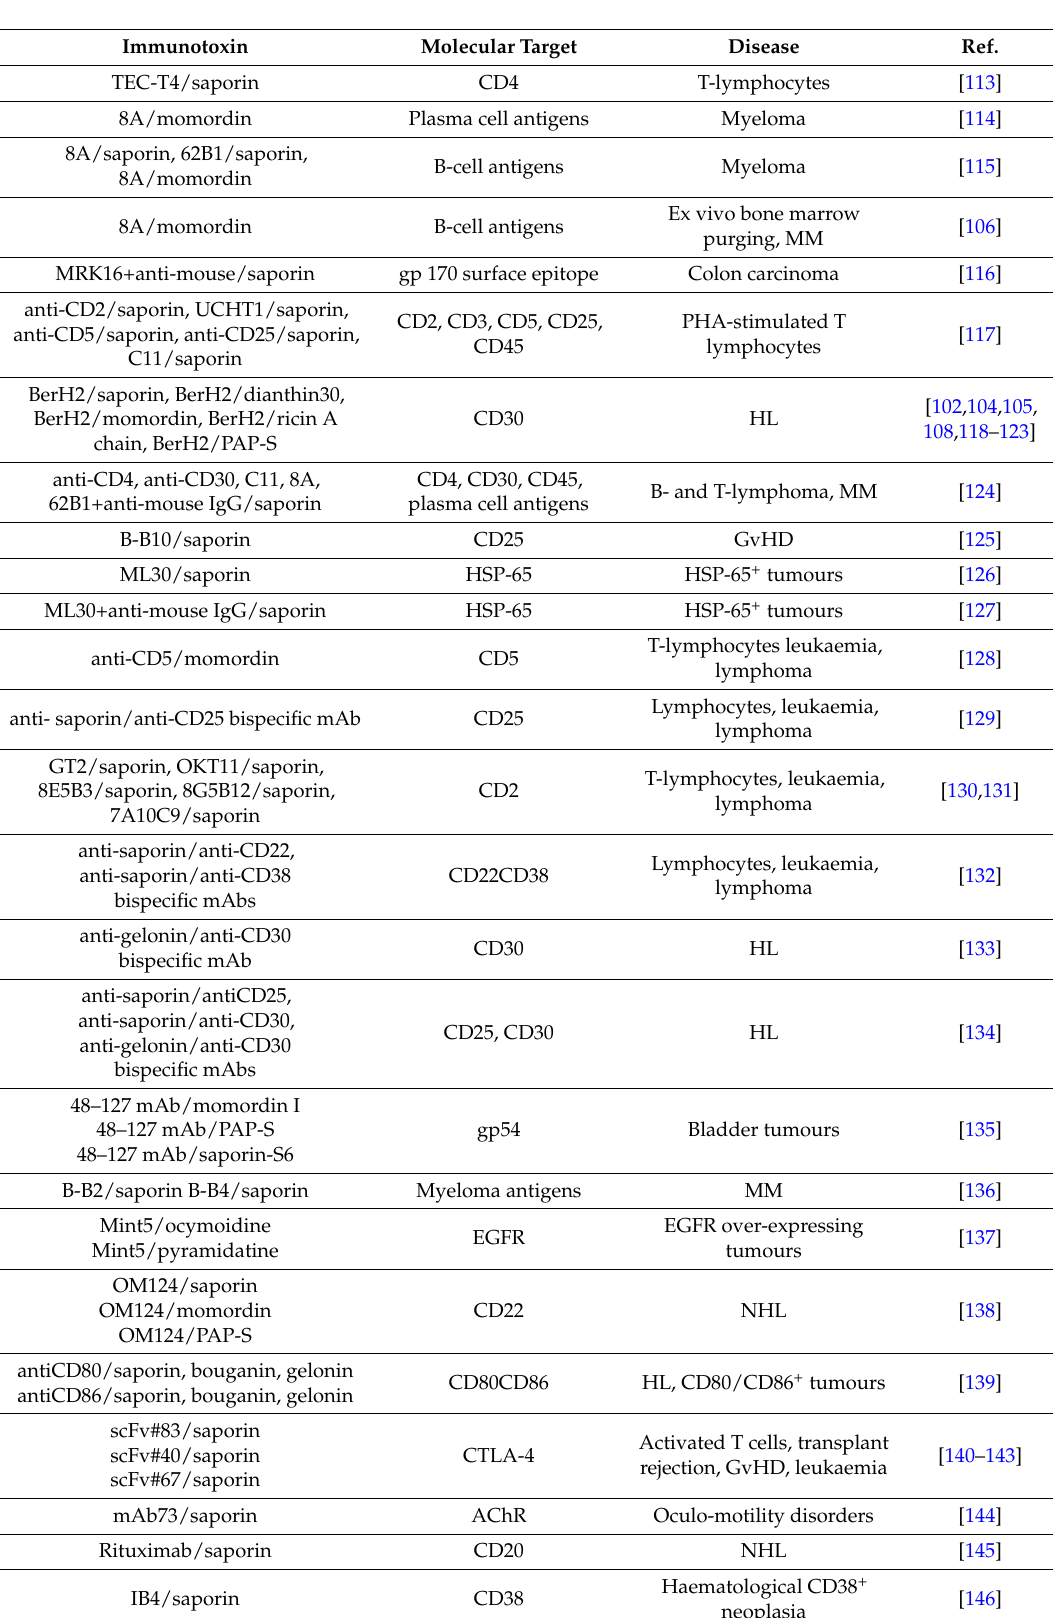
Abbreviations: EGFR, epidermal growth factor receptor; gp, glycoprotein; GvHD, Graft versus Host Disease; HL, Hodgkin’s Lymphoma; HSP, heat shock protein; MM, multiple myeloma; NHL, Non-Hodgkin’s Lymphoma; PHA,